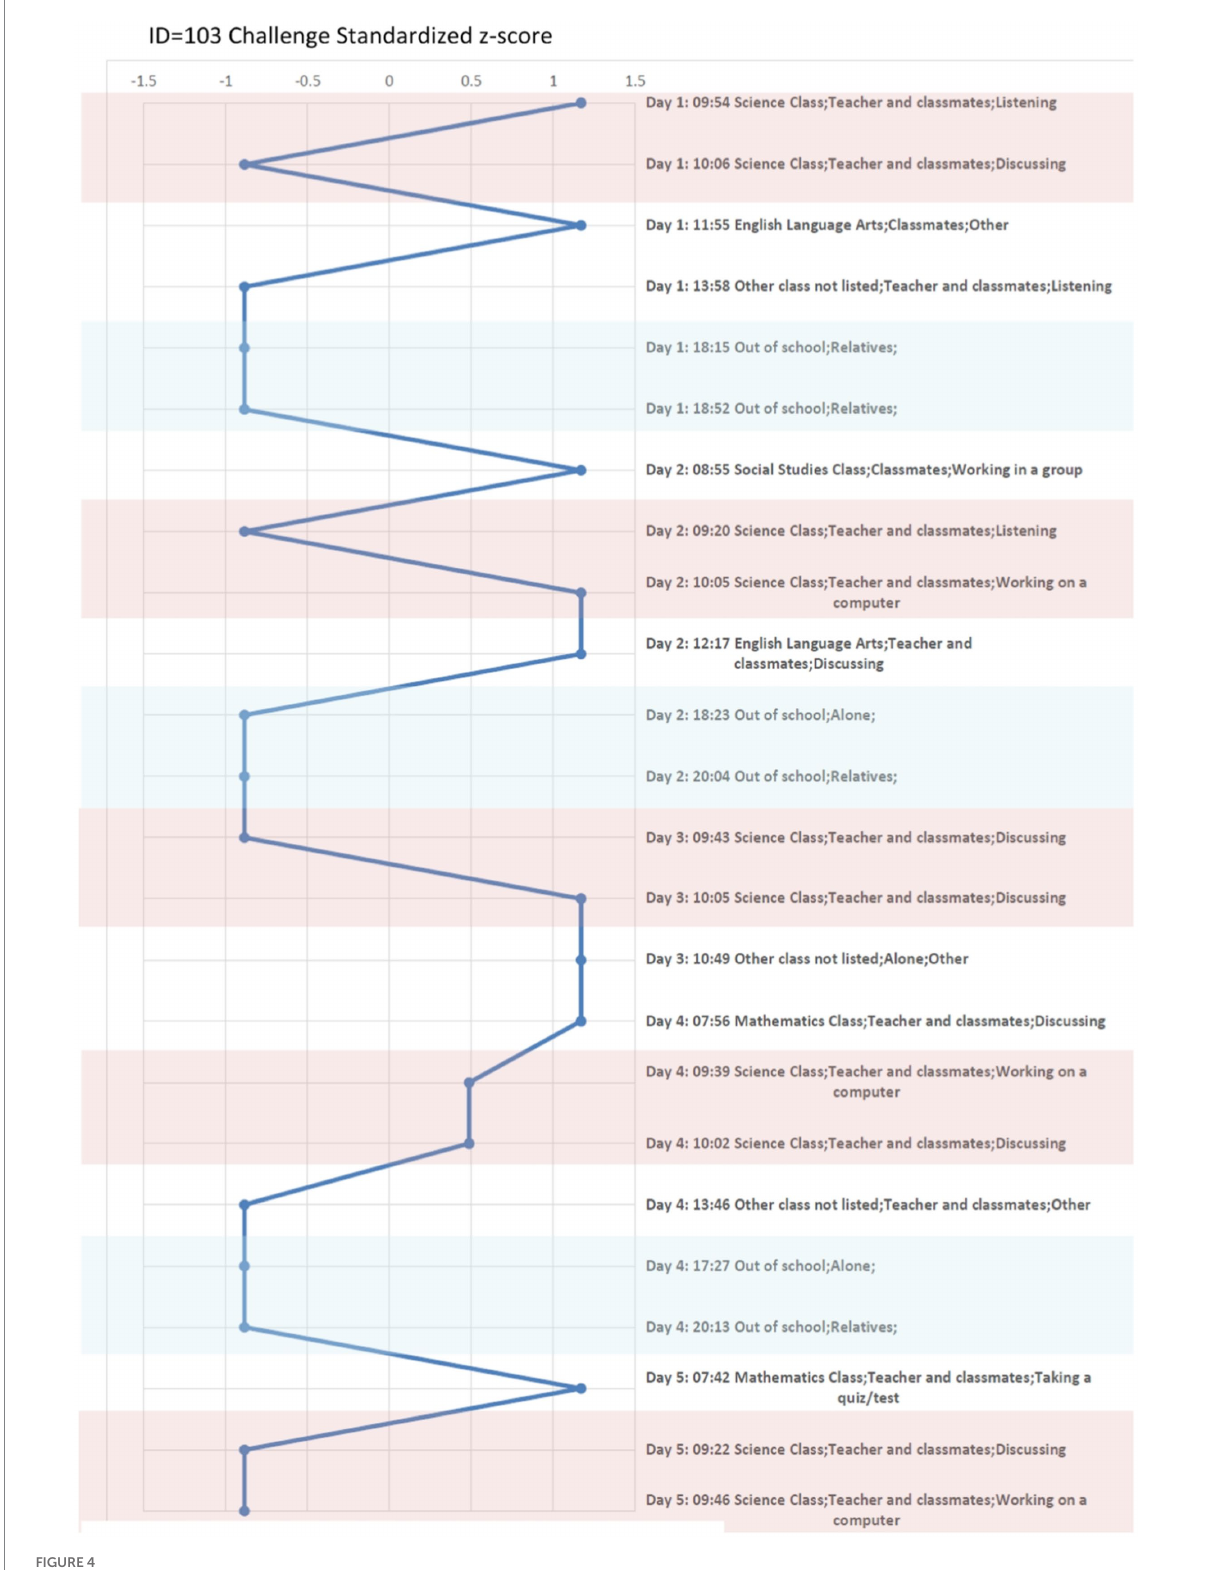
FIGURE 4 Collins (Above Average student) Experienced “Challenge” in situ across Context. Report Z-score Over 4 days. Pink color marks the moments in science classroom, and the light blue color marks the moments when a student is out of the